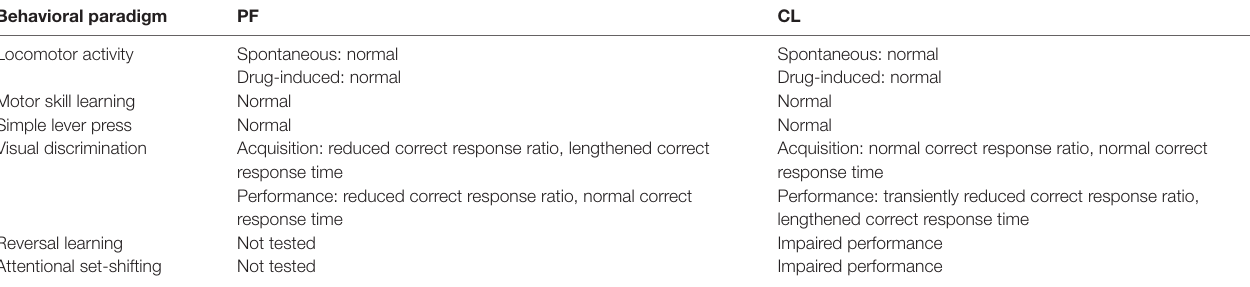
TABLE 1 | Behavioral impacts of selective targeting of PF and CL thalamostriatal